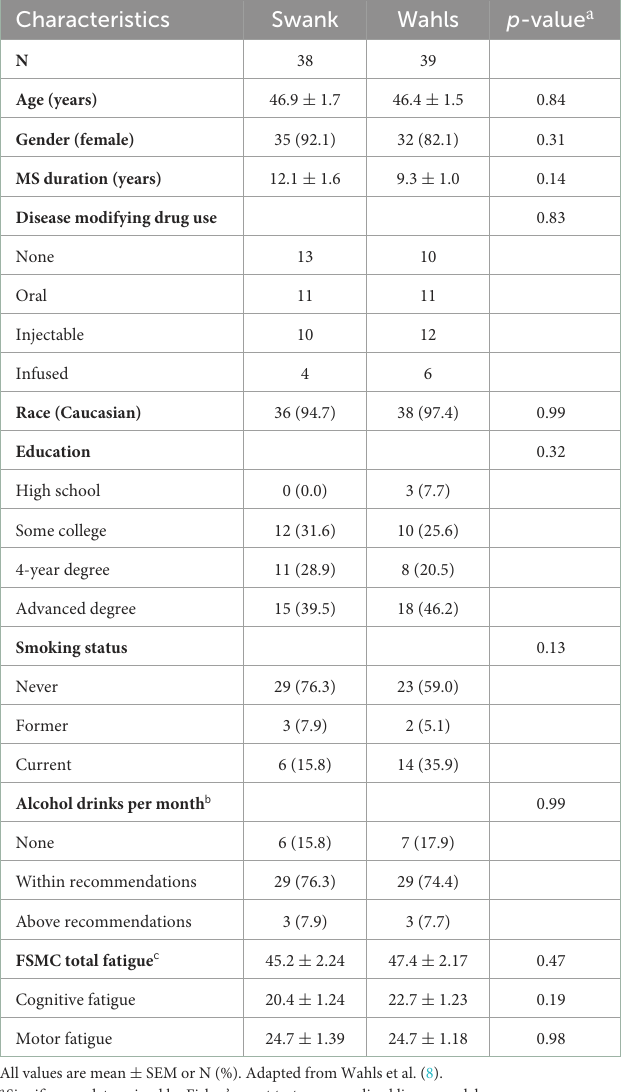
TABLE 1 Baseline characteristics of participants with RRMS who completed the primary study endpoint at 12-weeks.